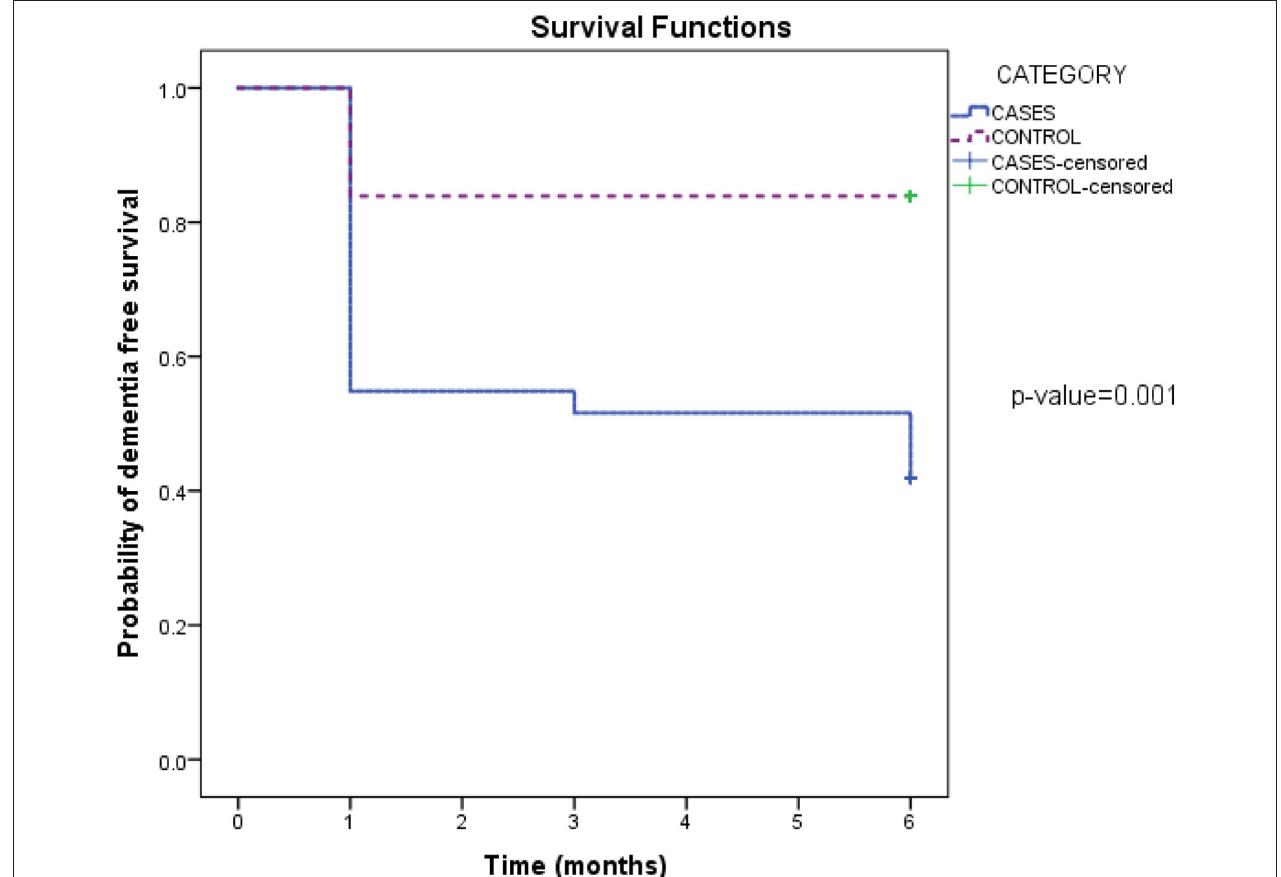
FIGURE 1 | Estimate of survival free of dementia over 6 months between cases and